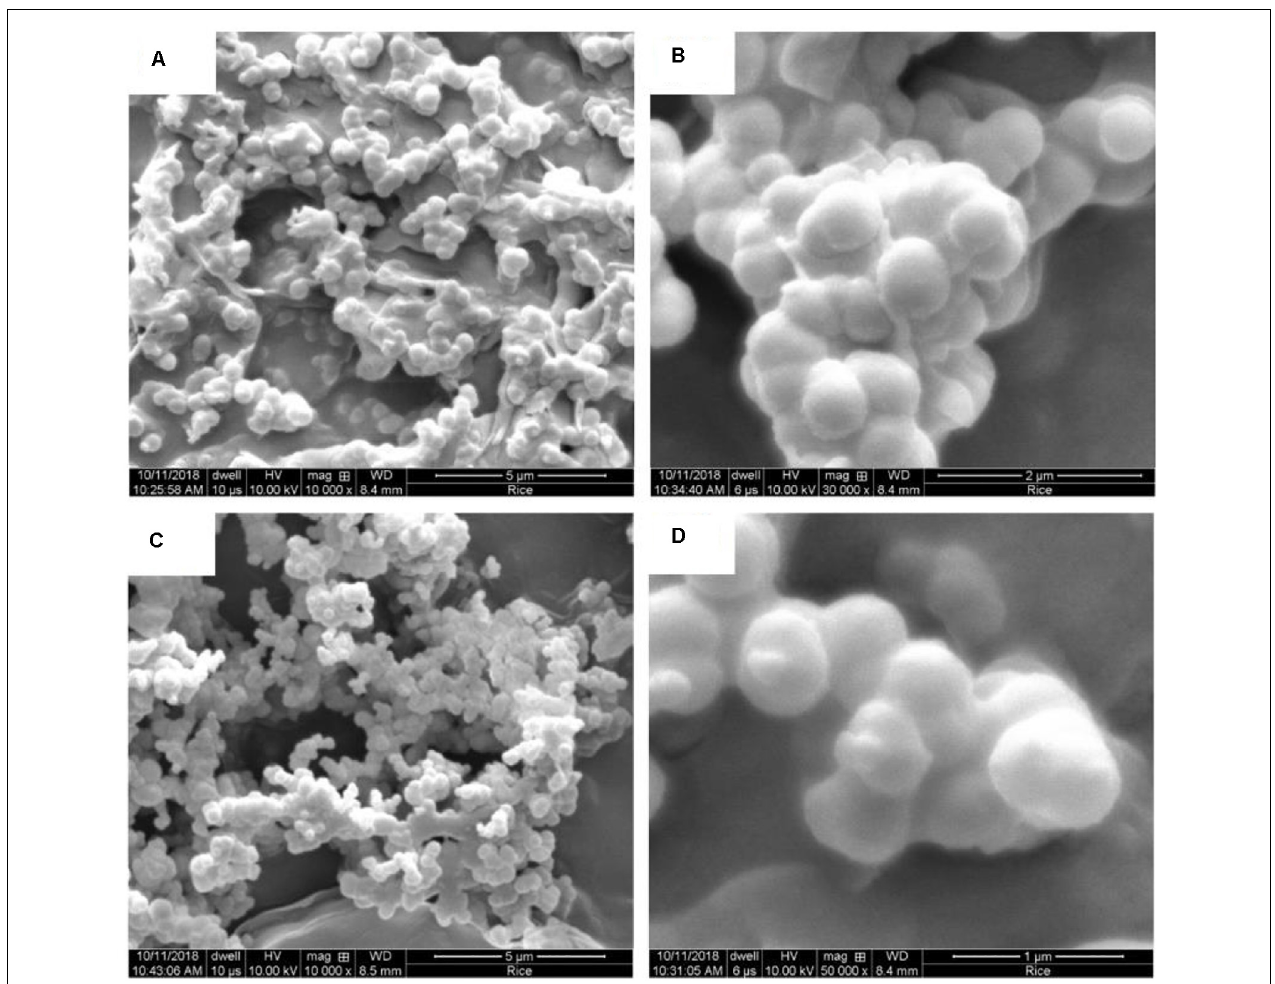
FIGURE 5 | SEM images of Ca-DTPMP particles prepared in the presence of (A,B) Hyamine and (C,D)